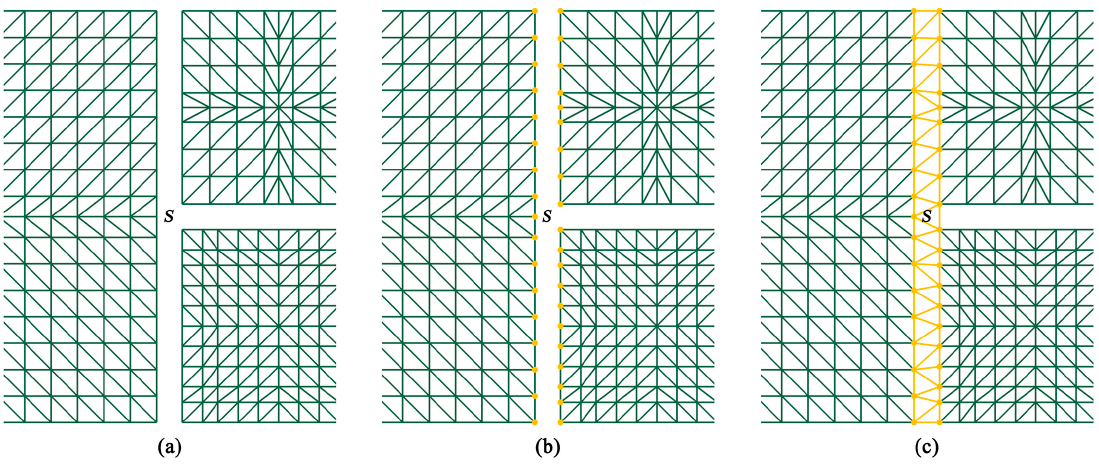
Figure 6. Creation process of a DSS: ( a ) M-blocks separated by gaps. ( b ) Original vertices needed to generate the DSS. ( c ) Triangulated DSS.